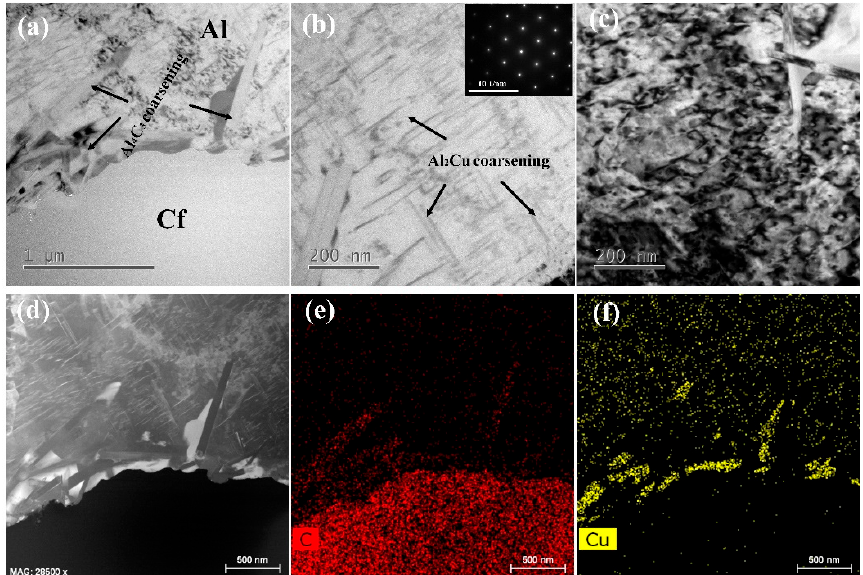
Figure 11. ( a – c ) TEM micrographs, ( d ) HADDF STEM micrograph and ( e , f ) corresponding EDS mapping results for the 4 vol. % SCFs/2024 Al composite after tensile test at 523 K.